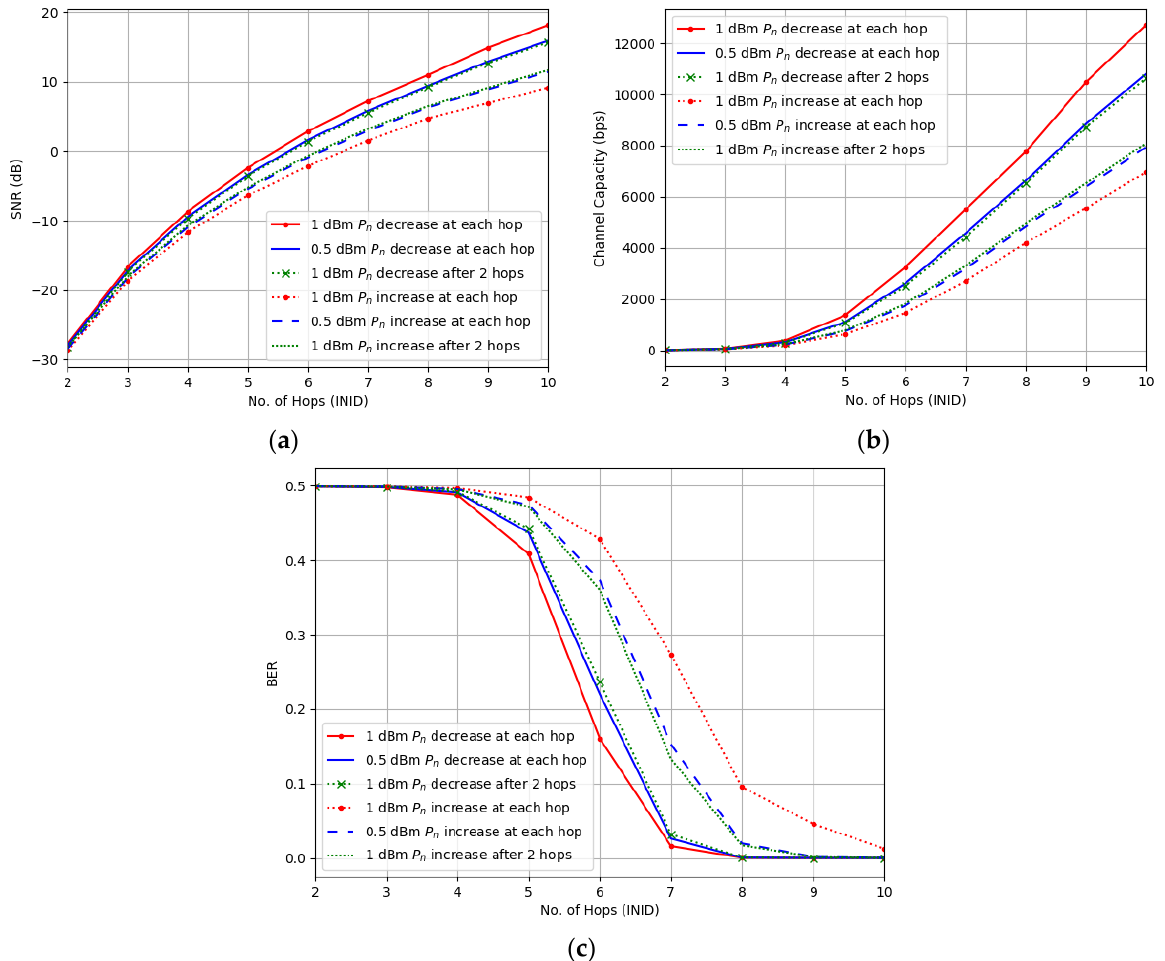
Figure 9. Multihop underground MI communication system’s performance for INID of channel states between hops, with hop 1 subject to an average noise power of 𝑃 𝑛 = − 93 dBm. The panels show the variation of the ( a ) SNR (dB), ( b ) channel capacity (bps) and ( c ) BER with the noise power across hops.